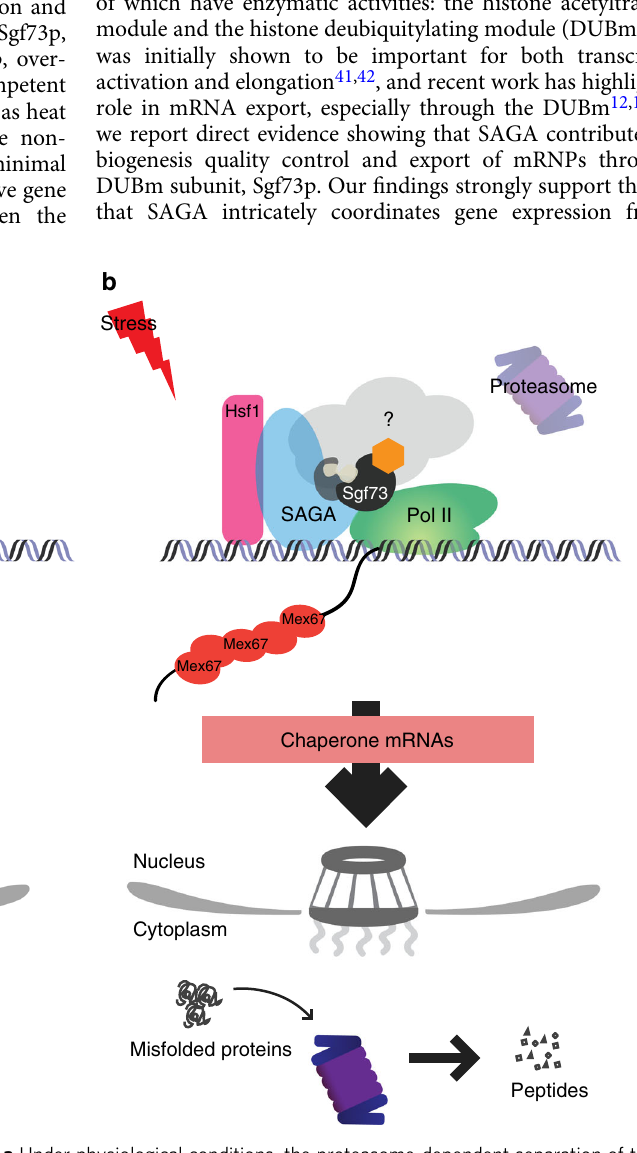
Fig. 7 Sgf73p-mediated mRNP surveillance facilitates proteostasis. a Under physiological conditions, the proteasome-dependent separation of the Sgf73- DUBm from SAGA is required for surveillance of mRNP biogenesis. The physical interaction between Sgf73p and Yra1p facilitates proper chromatin recruitment and RNA binding of Yra1p. b During stress, Sgf73p accumulates in the UASs of speci fi c genes, and Sgf73p retention initiates the Mex67p- mediated non-canonical mRNA export pathway to bypass quality control. Overall, Sgf73p regulates the plasticity of gene expression by interacting with key mRNA export factors to maintain proteostasis and maximize cell survival under environmental